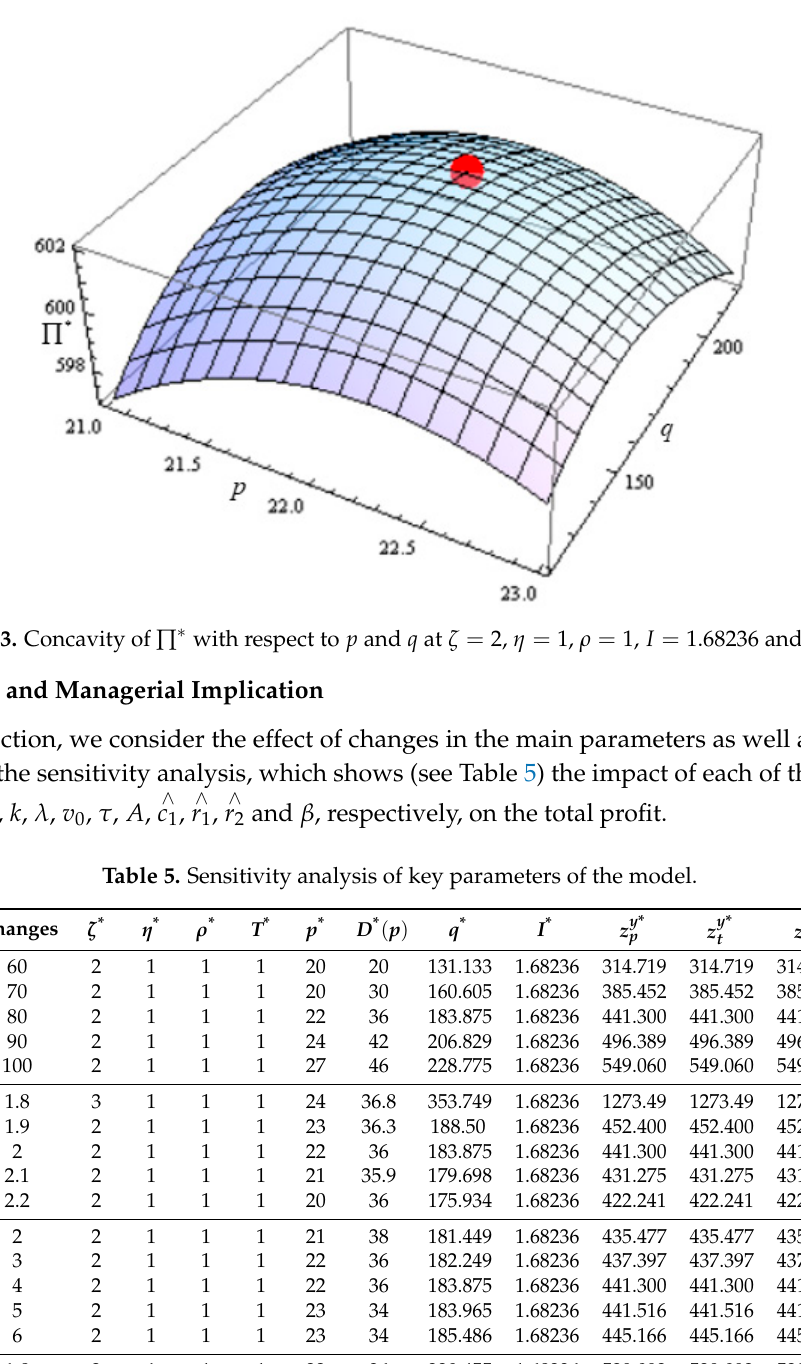
Figure 2. The contour of the objective function